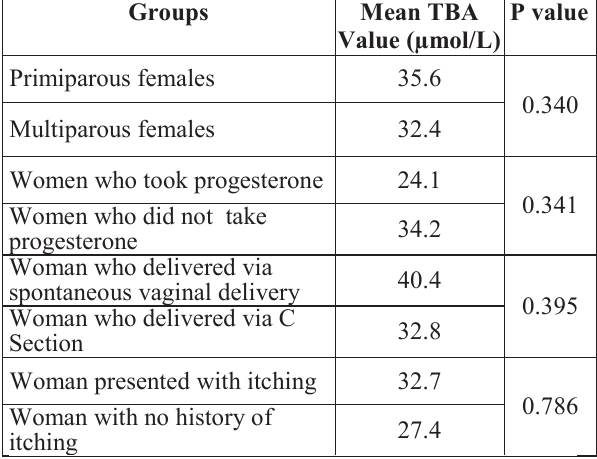
Table-1: Serum Total Bile Acid levels in various groups of patients